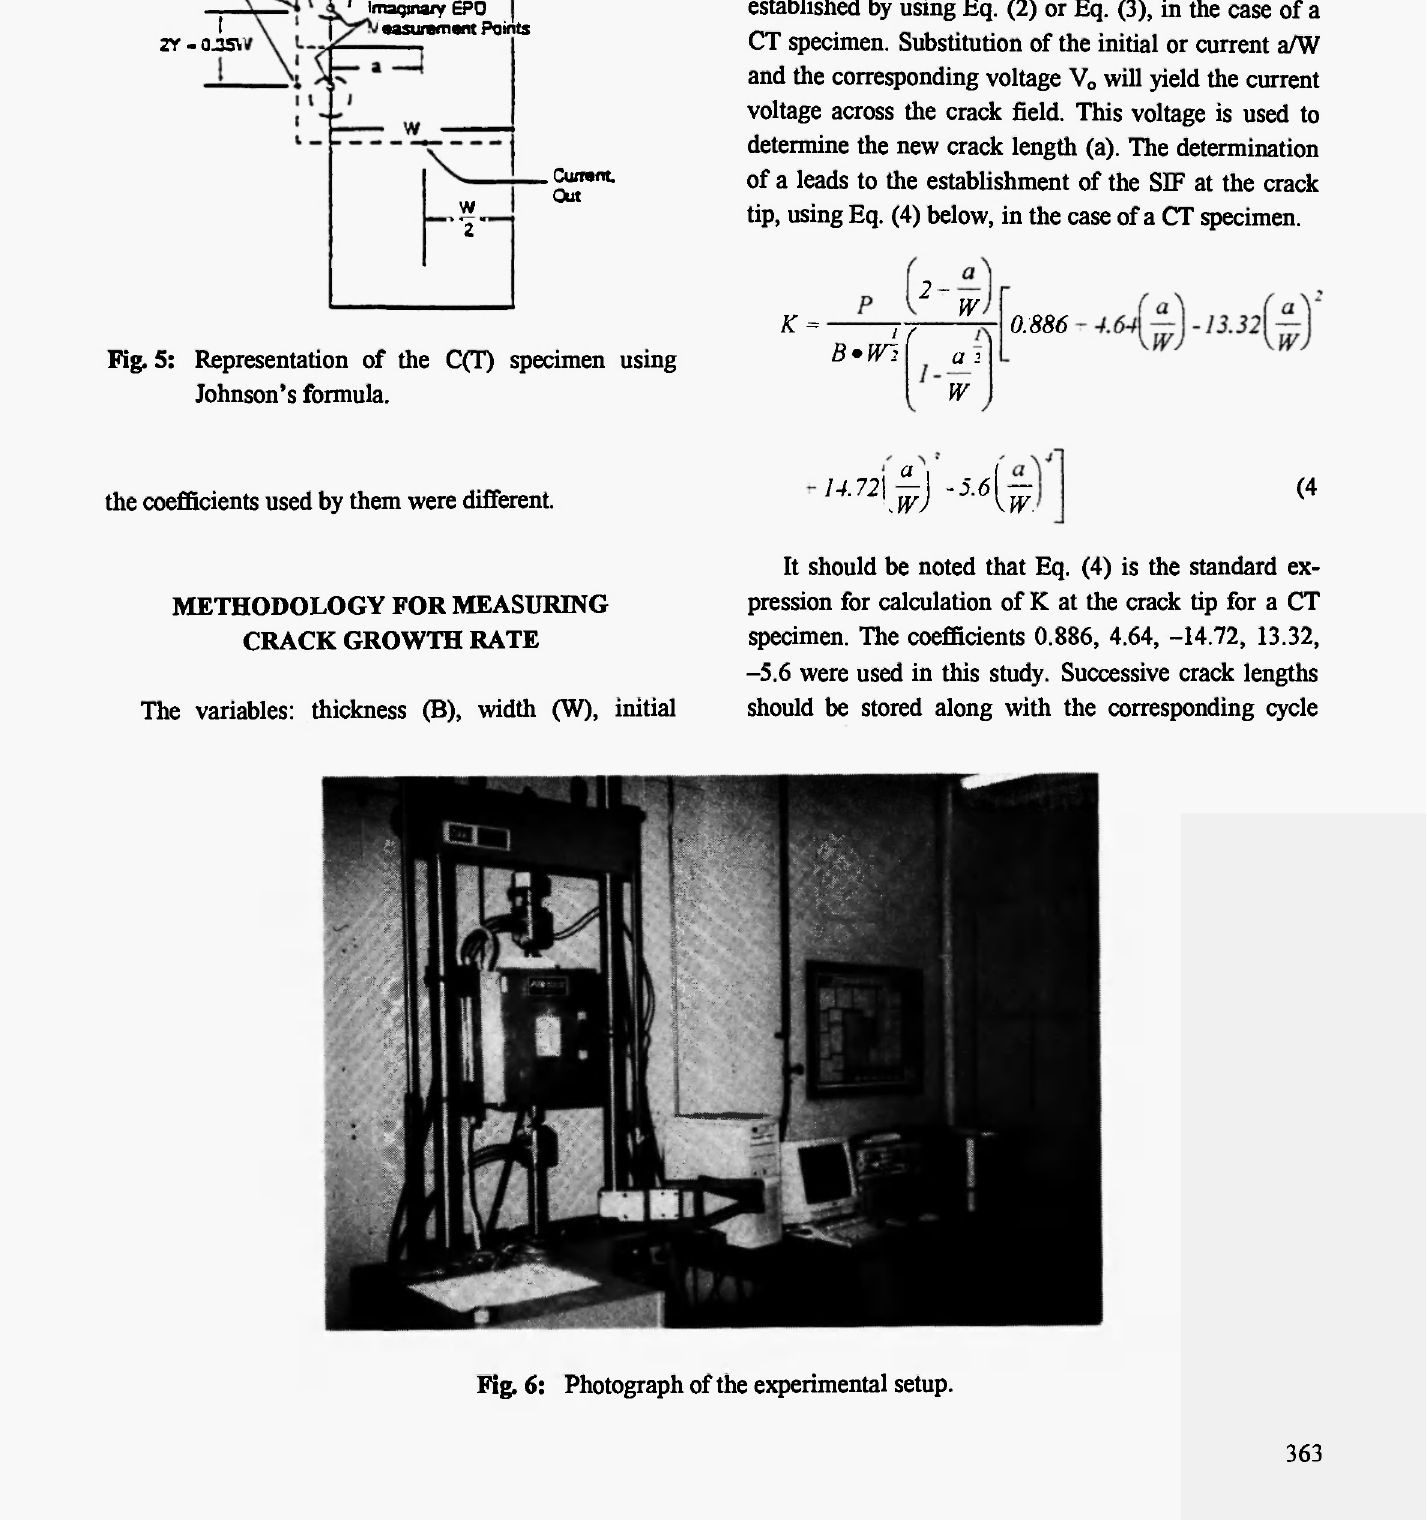
Fig. 5: Representation of the C(T) specimen using Johnson's formula.